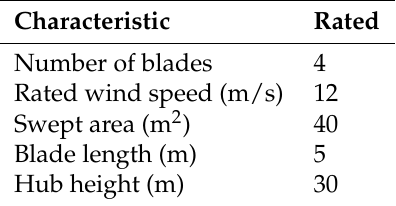
Figure 8. Four bladed 10 kW vertical axis wind turbine adapted to fit on an existing telecommunications tower to the left and the stator of the permanent magnet synchronous generator mounted on a tower section during construction to the right. Table 5. Turbine parameters for the 10 kW VAWT adapted to an existing telecommunications